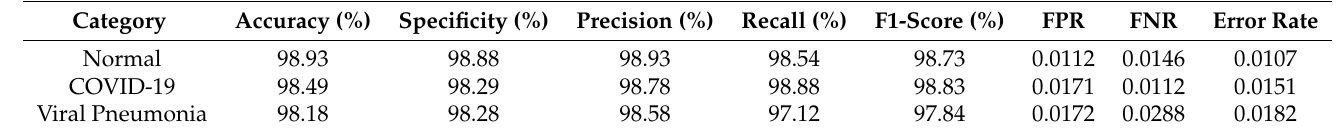
Table 7. Performance measures for GoogleNet after optimization for X-ray images.